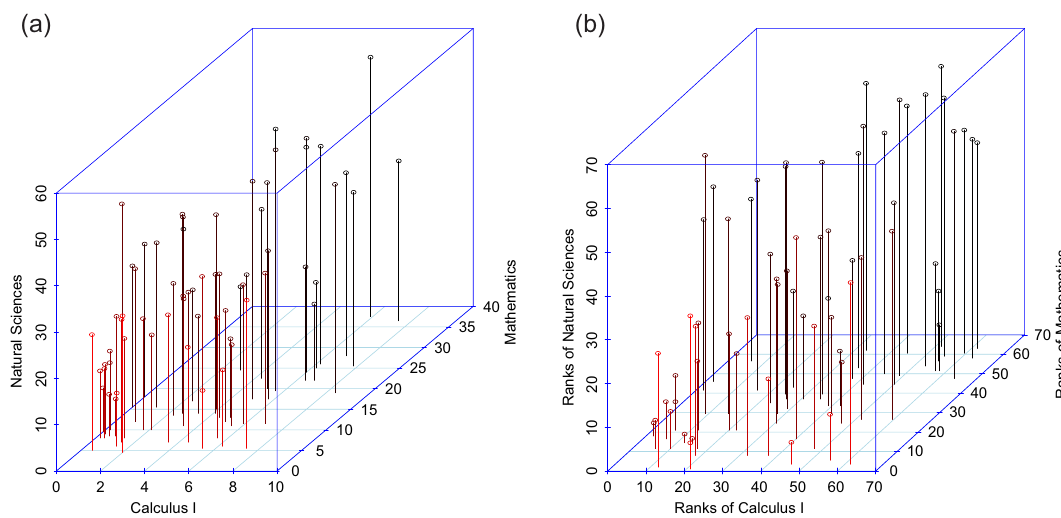
Figure 4. Data of 2013. (a) Scatterplot between Calculus I , Mathematics and Natural Sciences , from red to black color in increasing order in relation to the “ Mathematics ” axis. (b) Scatterplot between ranks of Calculus I , ranks of Mathematics and ranks of Natural Sciences , from red to black color in increasing order in relation to the “ Ranks of Mathematics ” axis.